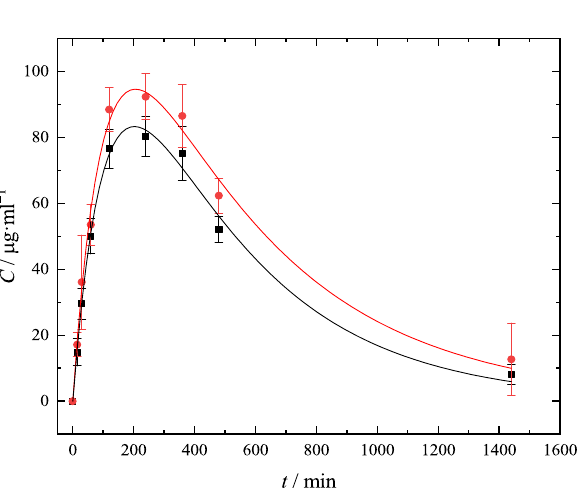
Figure 12. Pharmacokinetics of fullerene C 60 in whole blood after oral administration to mice of an oil solution (– ■ –) and micellar form of fullerene C 60 (– –). Dots are experimental points; lines represent Eq. 2. ●